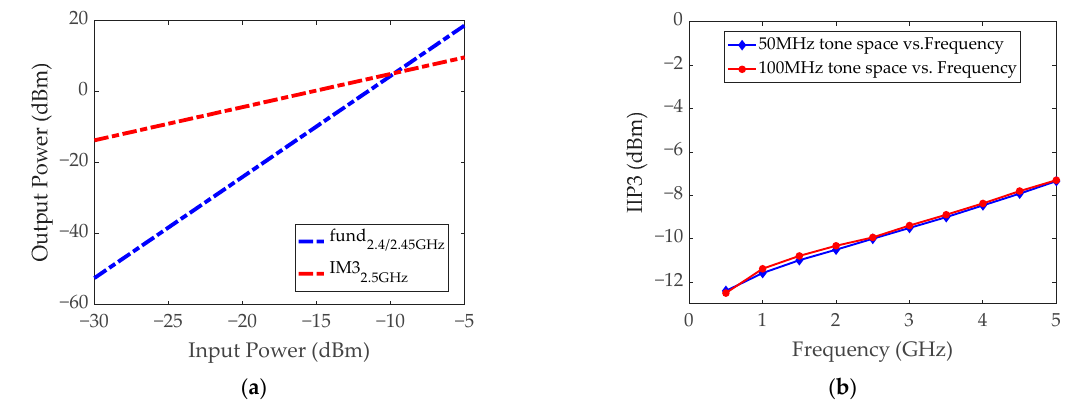
Figure 7. IIP3 of proposed LNA ( a ) at 𝑓𝑜 = 2.4 𝐺𝐻𝑧 with 50 MHz tone space ( b ) across 0.5 to 5 GHz frequency range with 50 and 100 MHz tone spacing.